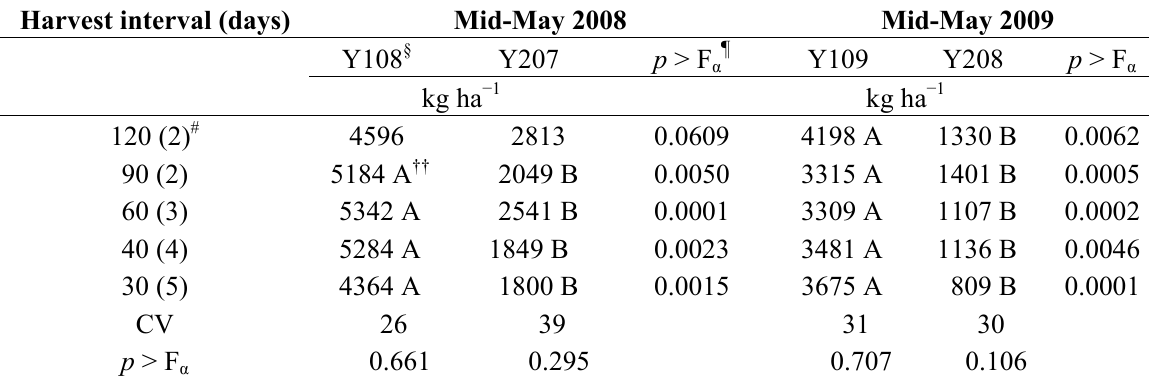
Table 5. Effects of harvest interval and harvest-duration † on post-season recovery yield per area of mixed native grass stands ‡ in mid-May of two consecutive